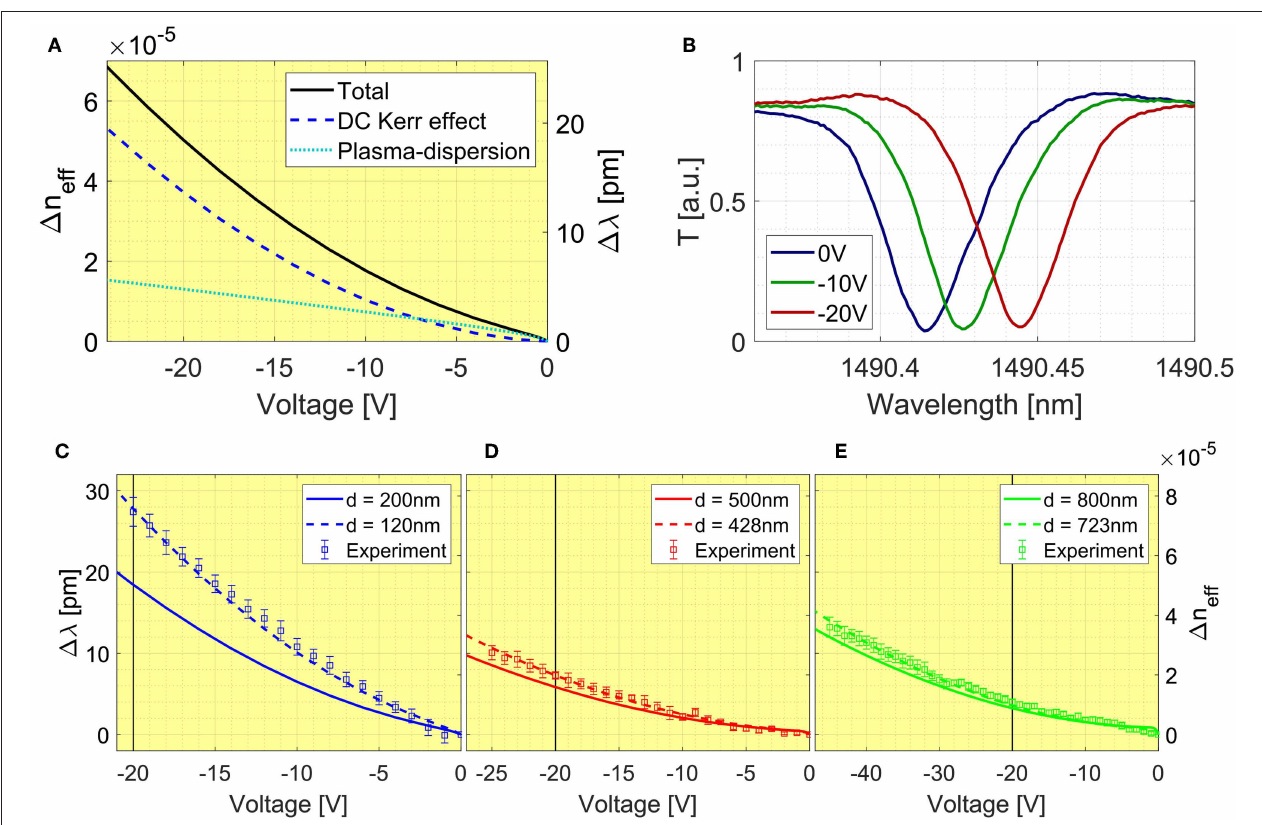
FIGURE 6 | (A) Simulated effective index variation and corresponding resonance wavelength shift for d = 200 nm considering plasma-dispersion, DC Kerr effect and both the effects. (B) Transmission spectrum of the resonator with d = 200 nm and for different values of the reverse bias. (C–E) Comparison between the experimental and the simulated resonance wavelength shift for d = 200 nm , d = 500 nm , and d = 800 nm